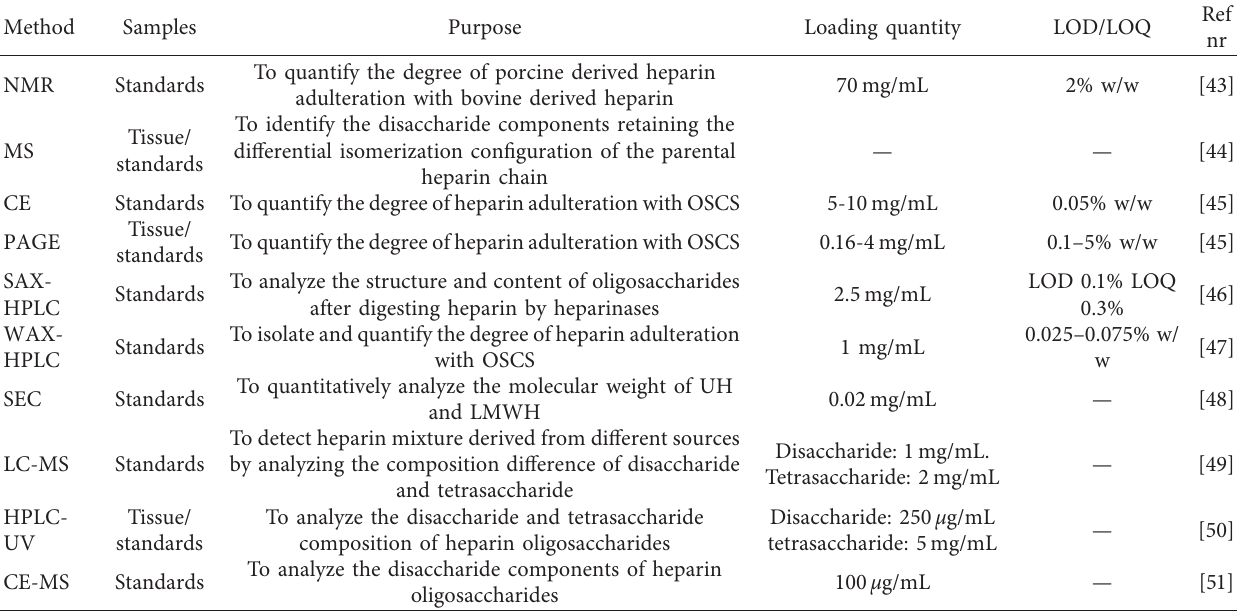
Figure 4: (a) The repeat disaccharide components of OSCS. (b) The sequence of pentasaccharide binds with antithrombin III and repeat disaccharide components of heparin ( R 1 � H SO 3 − ; R 2 � SO 3 − ; R 3 � H SO 3 − , Table 1: The characteristics of routine heparin analysis and detection methods.